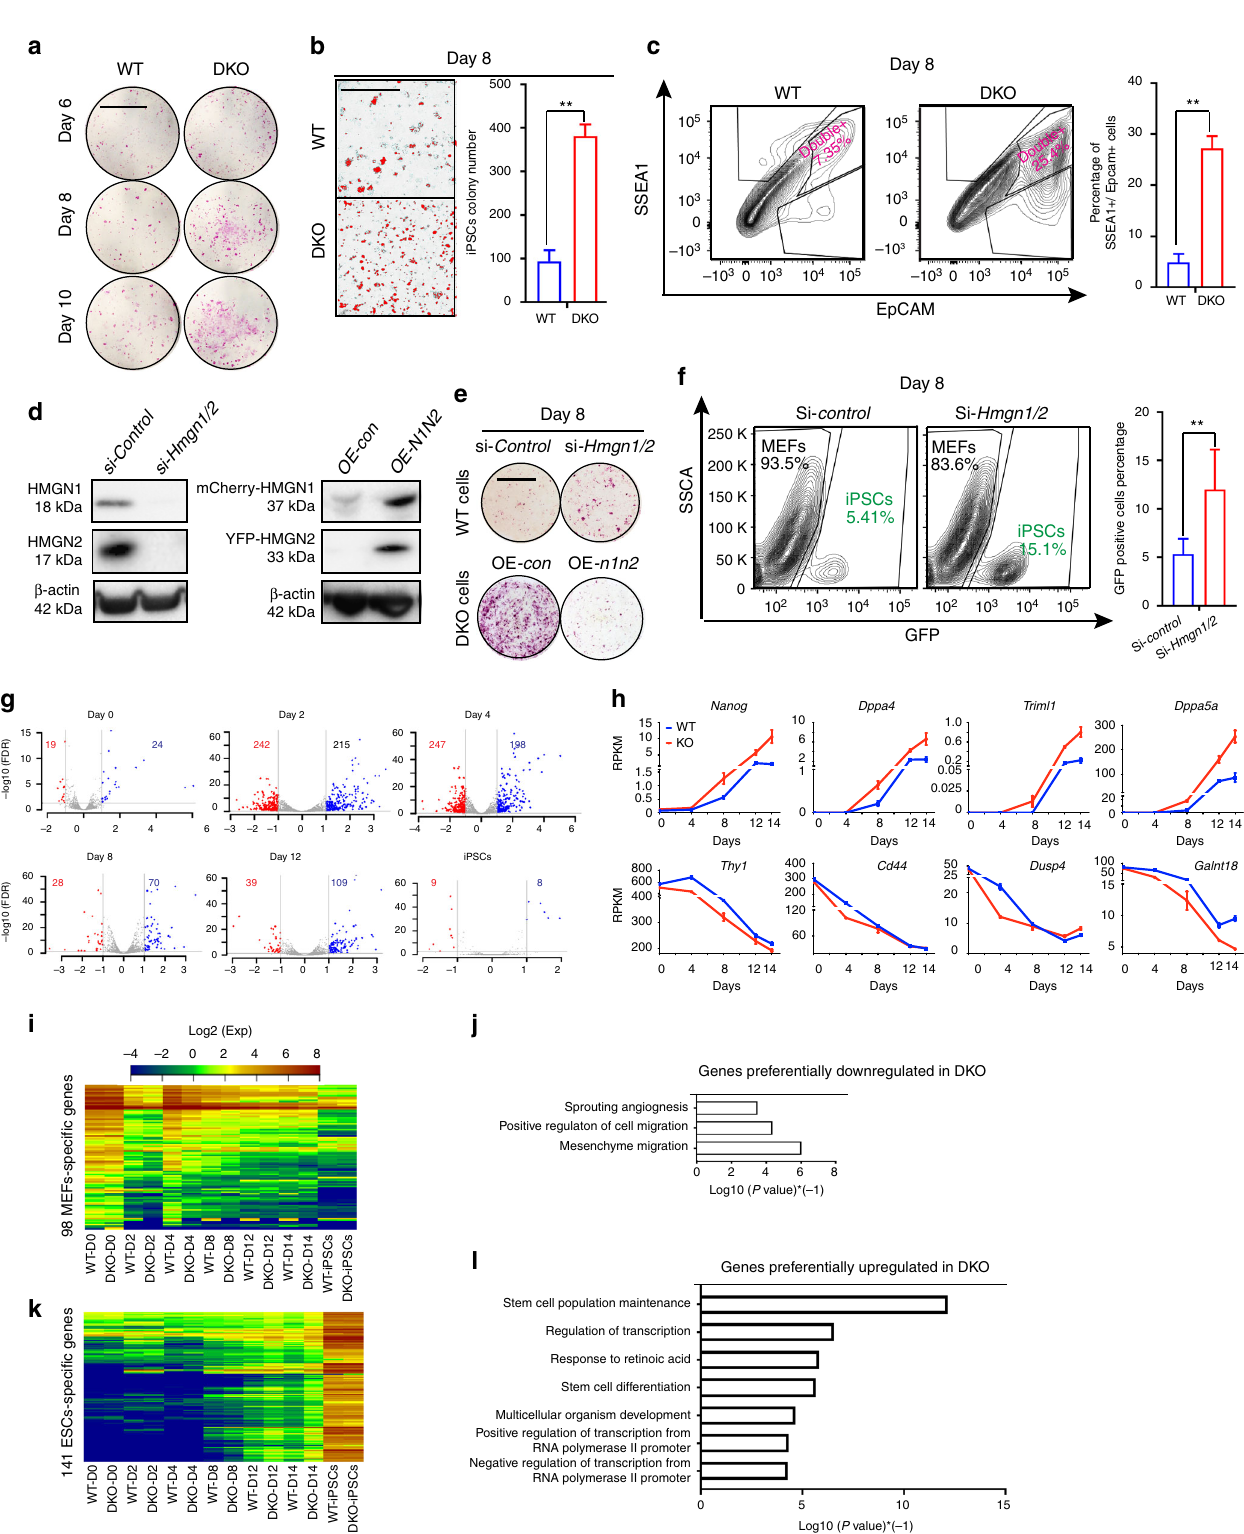
is twice that seen in WT cells, suggesting an enhanced rate of conversion to an ESC-speci fi c epigenetic landscape. In fully reprogramed cells, the level of modi fi cation is the same regardless whether the iPSCs were derived from WT or DKO MEFs (Fig. 4a). Similar changes are seen in the location of the H3K4me1 signals. At early reprogramming stages (Fig. 4b, day 2,